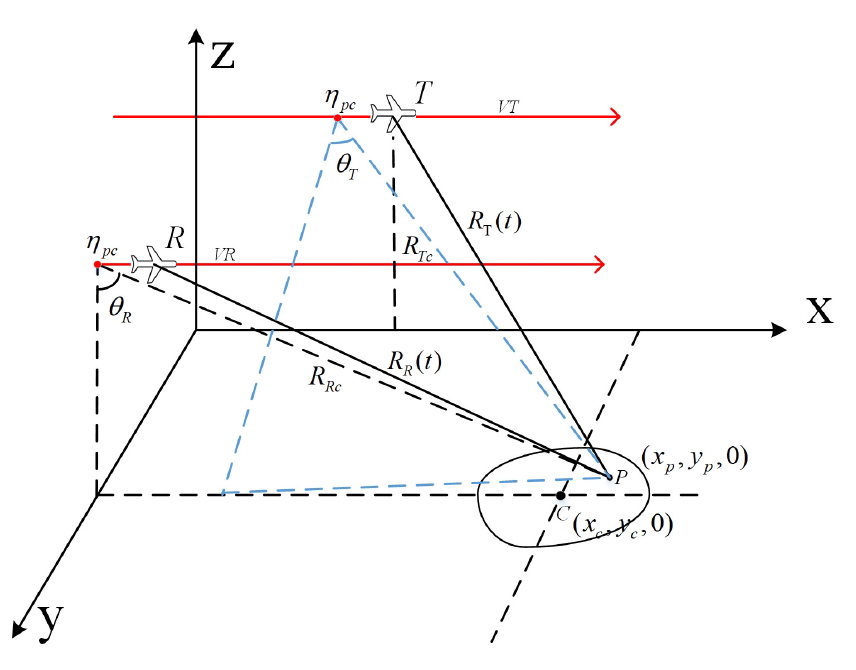
Figure 1. Geometry of forward-looking bistatic